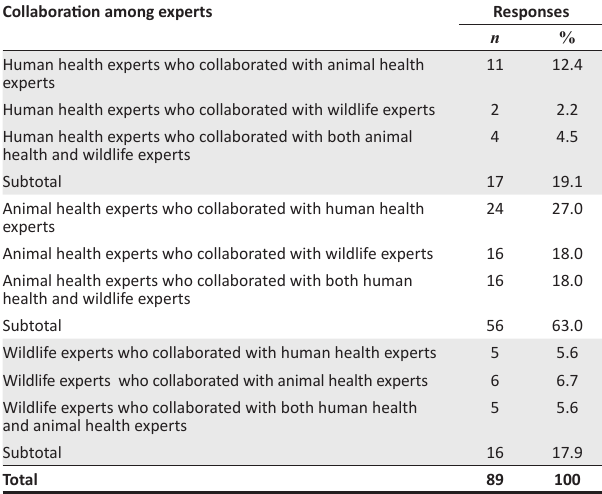
TABLE 1: Proportions of health experts who had collaborated with other experts. Collaboration among